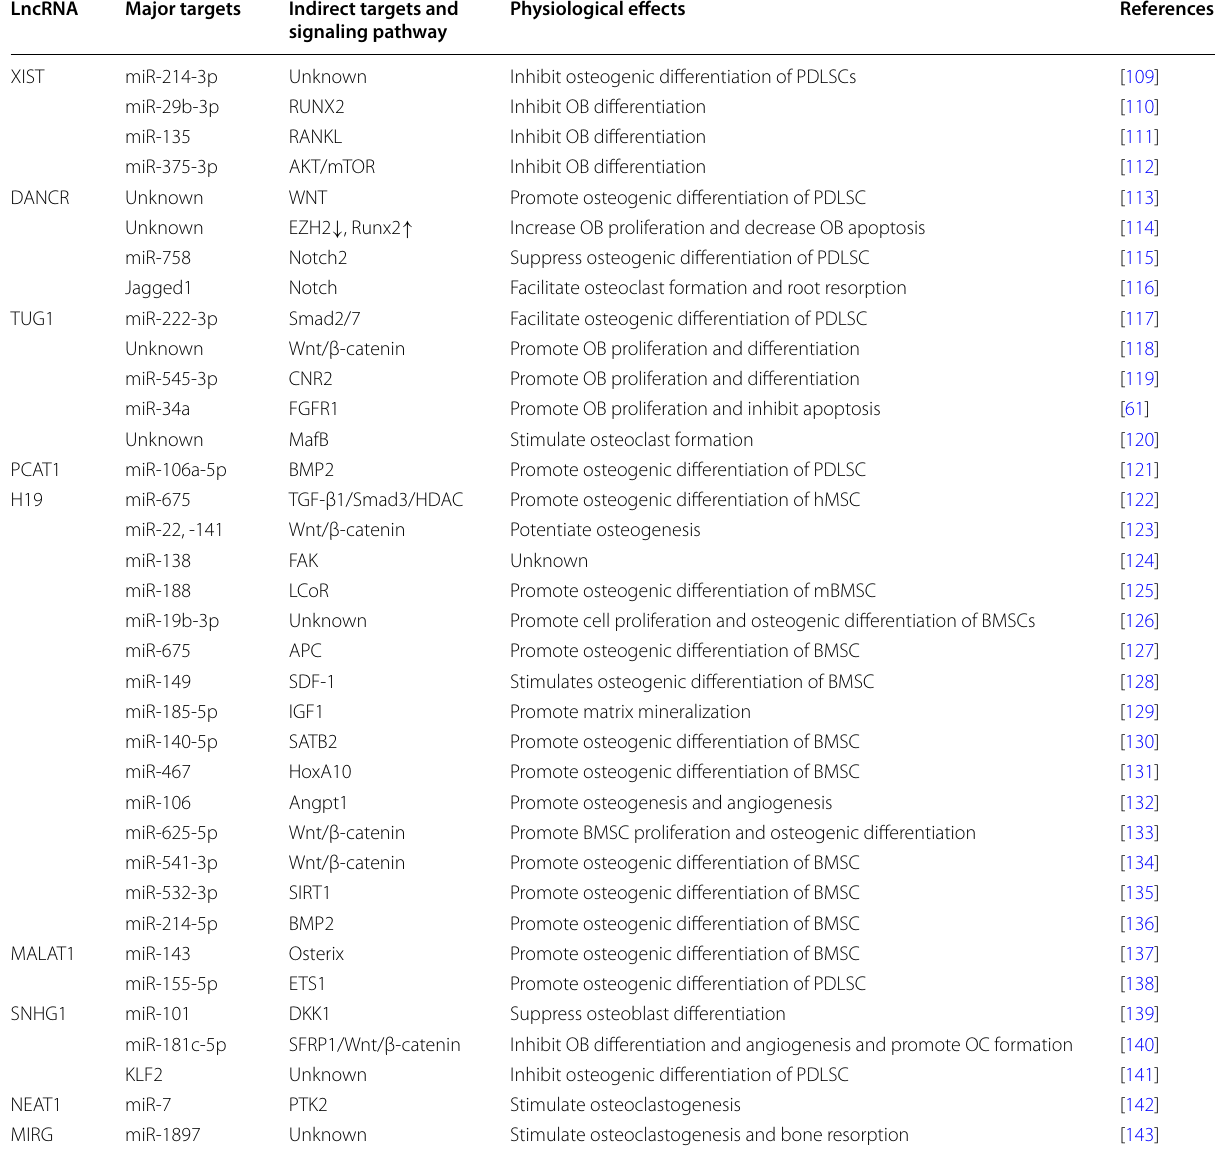
lncRNAs long non-coding RNAs, XIST X-inactive specific transcript, DANCR Differentiation antagonizing non-protein coding RNA, EZH2 Enhancer of zeste homolog 2, TUG1 Taurine upregulated 1, CNR2 cannabinoid receptor 2, MafB musculoaponeurotic fibrosarcoma oncogene homolog B, PCAT1 prostate cancer-associated ncRNA transcript 1, FAK Focal adhesion kinase, LCoR Ligand-dependent corepressor, SDF-1 Stromal Cell Derived Factor 1, IGF1 insulin-like growth factor 1, SATB2 Special AT-rich sequence-binding protein 2, HoxA10 homeobox A10, Angpt1 angiopoietin 1, SIRT1 sirtuin 1, MALAT1 metastasis-associated lung adenocarcinoma transcript 1, ETS1 E26 transformation specific-1, SNHG1 Small nucleolar RNA host gene 1, DKK1 Dickkopf-1, SFRP1 secreted frizzled-related protein 1, KLF2 Kruppel-like factor 2, NEAT1 nuclear paraspeckle assembly transcript